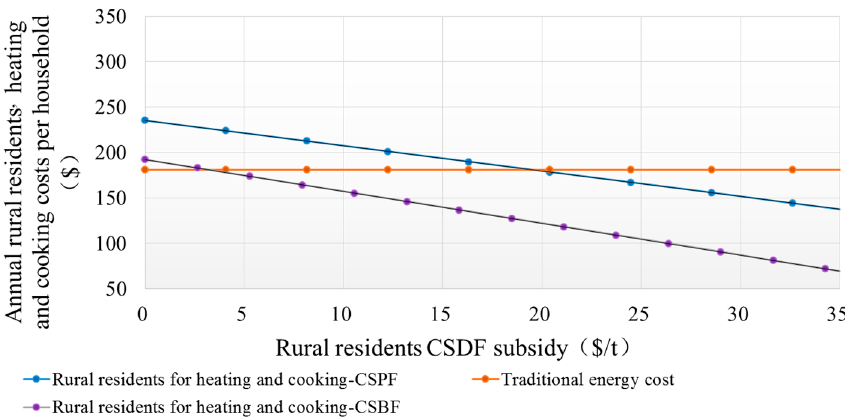
Figure 9. Influence of CSDF subsidy for rural residents’ heating and cooking on economic performance of a CSDF-DHS.